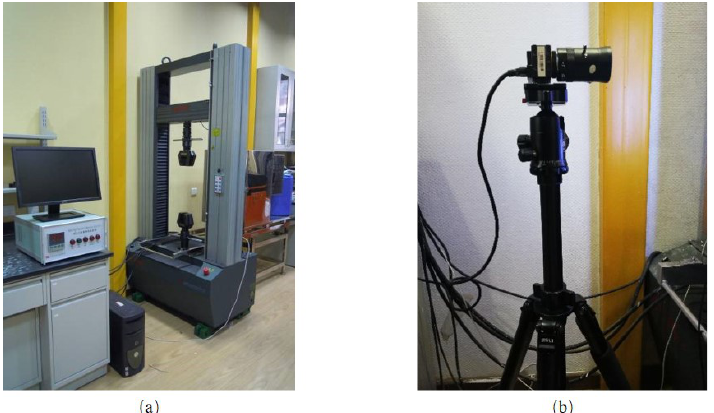
Figure 8. Test equipment: ( a ) MTS electronic universal testing machine; ( b ) MV-VD500SM/SC digital camera.